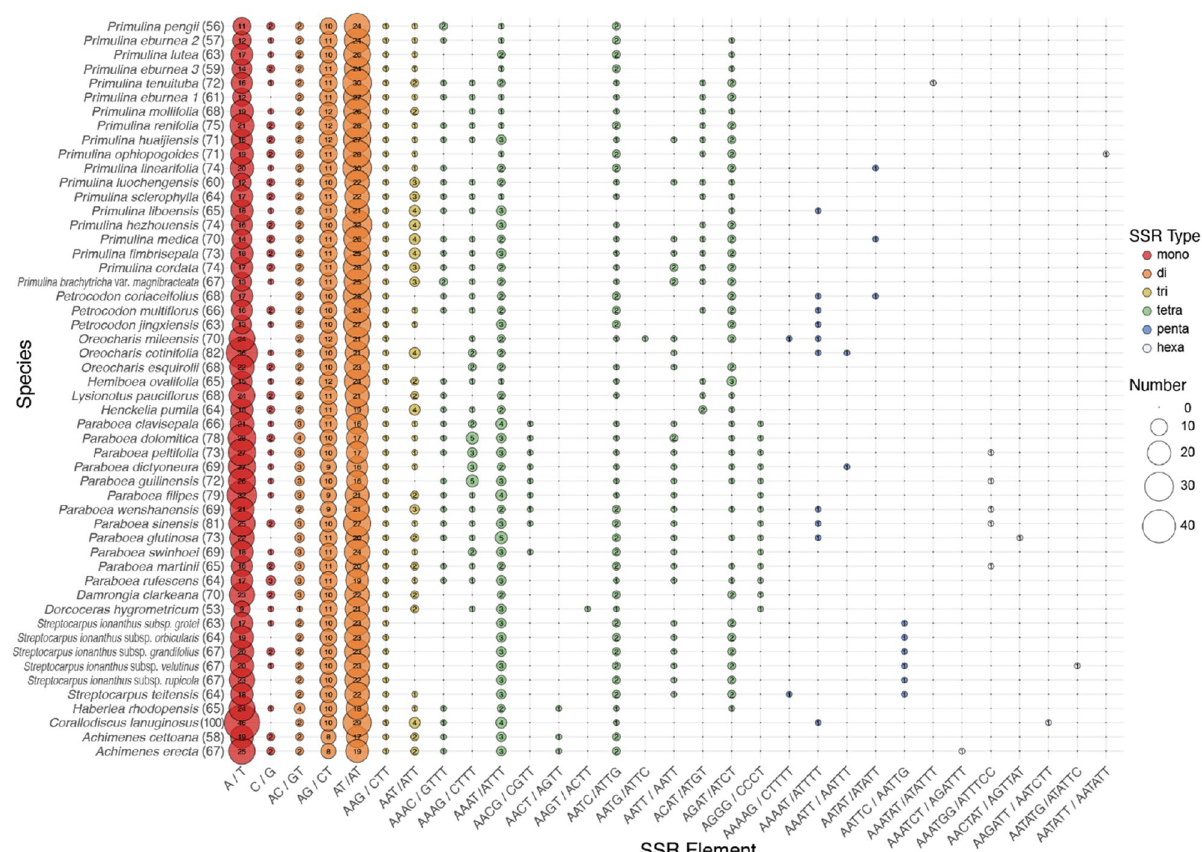
Figure 3. The balloon plot of detailed numbers of each SSR repeat pattern (unit pattern) of 52 Gesneriaceae plastomes with one IR excluded. Total number of SSRs in each plastome is shown in the parentheses after